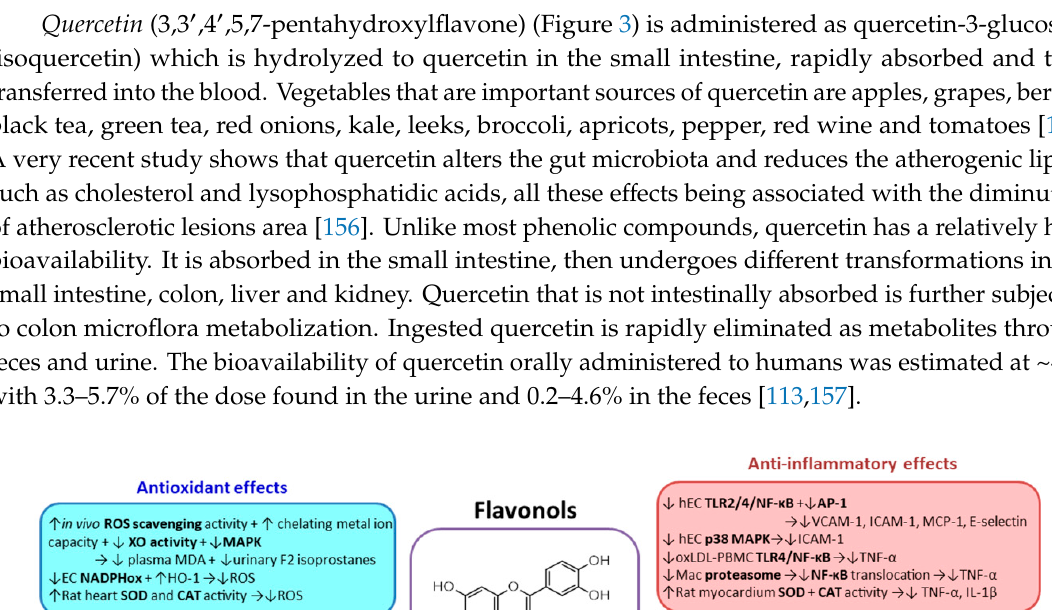
Figure 3. Quercetin chemical structure and beneficial effects in the context of cardiovascular diseases.